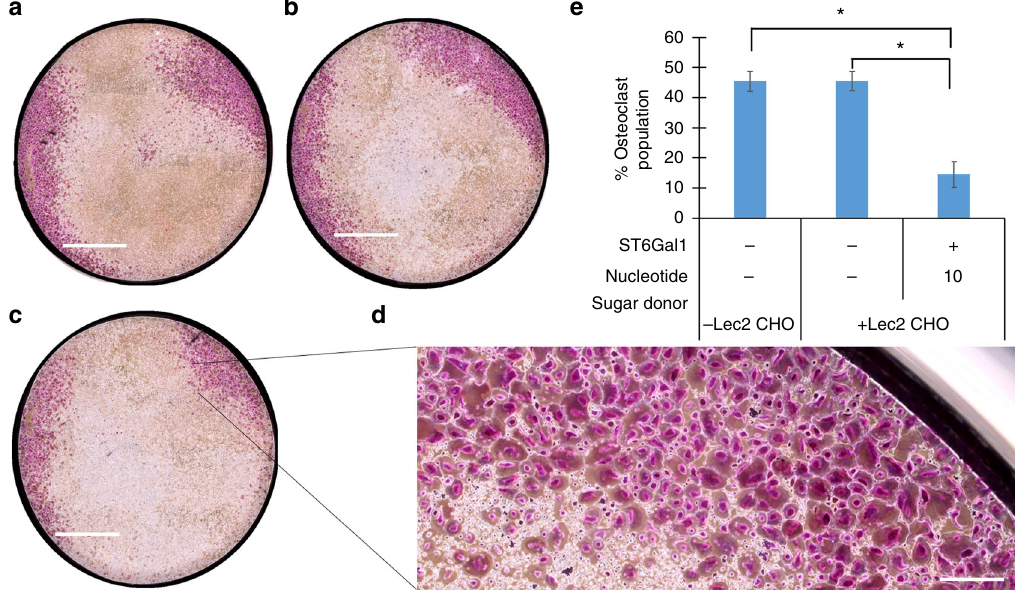
Fig. 6 Siglec-15 ligands impair osteoclast differentiation. Osteoclast differentiation was induced by the addition of hM-CSF and RANKL to the plated HOPs. On day 5, Lec2 CHO cells labeled with the high-af fi nity Siglec-15 glycan ligand, α 2-6-10 , or the native ligand, α 2-6-6 , were added to the plated cells. Quantitative analysis of osteoclast formation by a TRAP-staining assay was performed on day 7 on cells with no addition of Lec2 CHO cells (scale bar: 4 mm) ( a ), with the addition of unlabeled Lec2 CHO cells (scale bar: 4 mm) ( b ), and with the addition of Lec2 CHO cells labeled with α 2-6-10 (scale bar: 4 mm) ( c ). d Zoomed-in regions of osteoclast population (scale bar: 200 μ m). e Percentage of well containing osteoclast populations (area of purple/entire well area × 100%; n = 3, error bars are reported as SEM, signi fi cant difference compared with control was assessed using Student ’ s t test (* P <